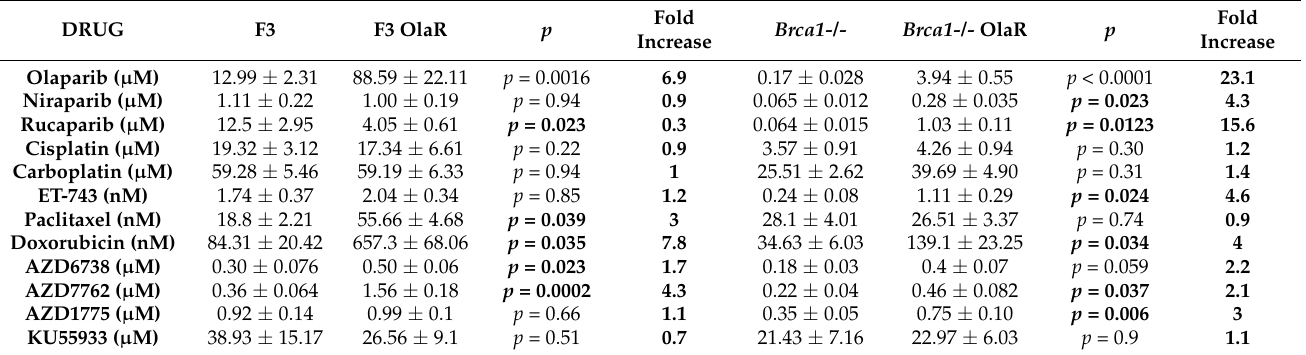
Figure 1. Characterization of F3, F3 OlaR, Brca1-/- and Brca1-/- OlaR cells. ( A ) Olaparib-dose response curve in F3 (grey line), F3 OlaR (dashed grey line), Brca1-/- (black line) and Brca1 -/- OlaR cells (dashed black line). Data are the mean ± standard deviation (SD) of four independent experiments. ( B ) Growth curves in F3 (grey line), F3 OlaR (dashed grey line), B Brca1 -/- (black line) and B Brca1-/- OlaR cells (dashed black line) at different times from seeding. Data are the mean ± SD of six replicates. ( C ). Flow cytometric analysis of DNA content in cells in F3, F3 OlaR, Brca1-/- and Brca1-/- OlaR cells treated or not with olaparib at different times (12 h, 24 h and 48 h) with the corresponding drug IC 50 . Table 1. IC 50 of different compounds in sensitive and olaparib resistant HR-proficient and -deficient ID8 cells. For statistical analyses unpaired t -test was